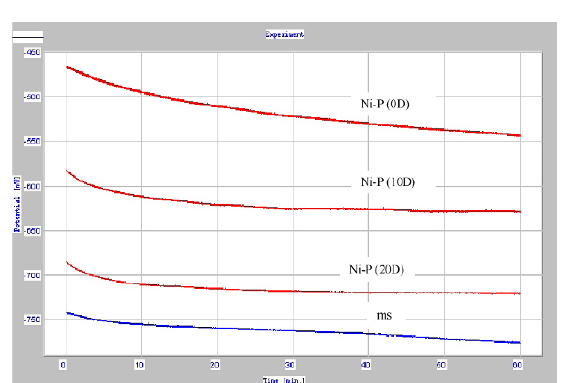
Figure 3. XRD analysis of as plated (a) mild steel (ms) (b) Ni-P and (c) Ni-P-PTFE coating.